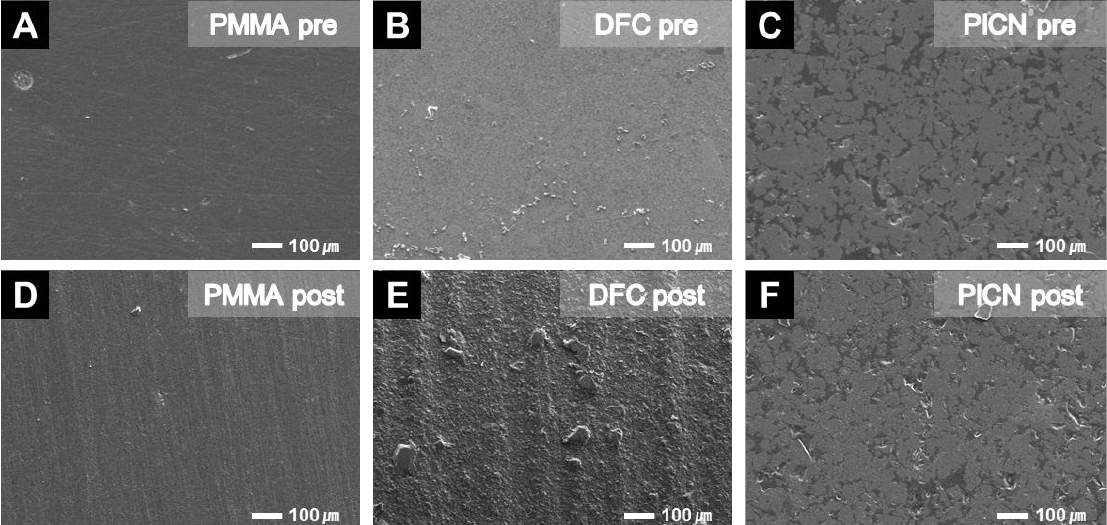
The Rz change in DCF appeared to be the largest, and shallow streaks appeared on the surface of the PMMA specimen. The PICN surface was almost unchanged. ( A ) PMMA pre, ( B ) DFC pre, ( C ) PICN pre, ( D ) PMMA post, ( E ) DFC post, and ( F ) PICN post.